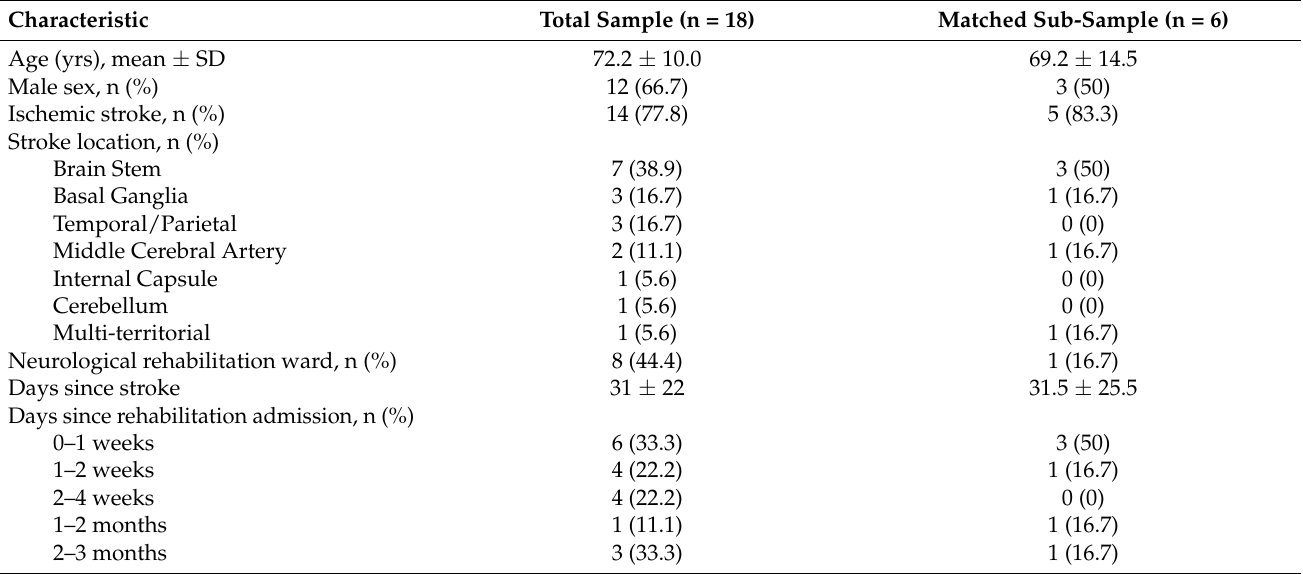
Table 1. Descriptive statistics and participant